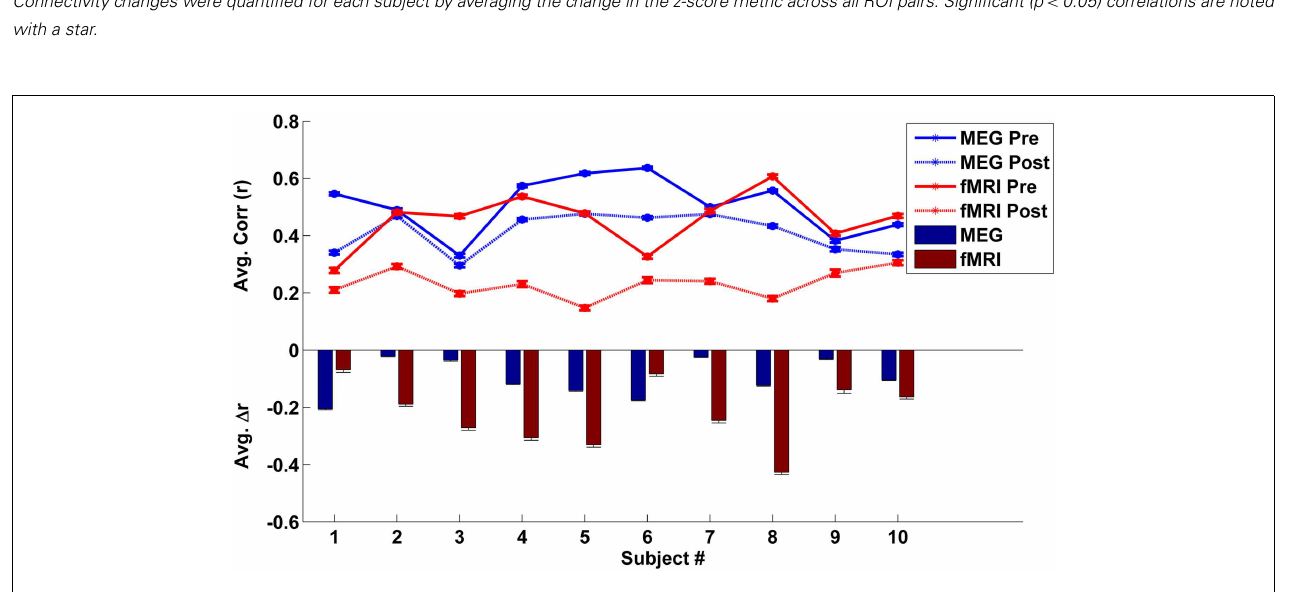
FIGURE 4 |Top panel – individual mean global correlations (averaged across all ROI pairs) are plotted for the MEG (blue lines) and fMRI (red line) eyes closed caffeine scans.The solid lines represent the mean global correlation from the pre-dose section while the dotted lines correspond to the post-dose section connectivity. Bottom panel – individual caffeine-induced changes in